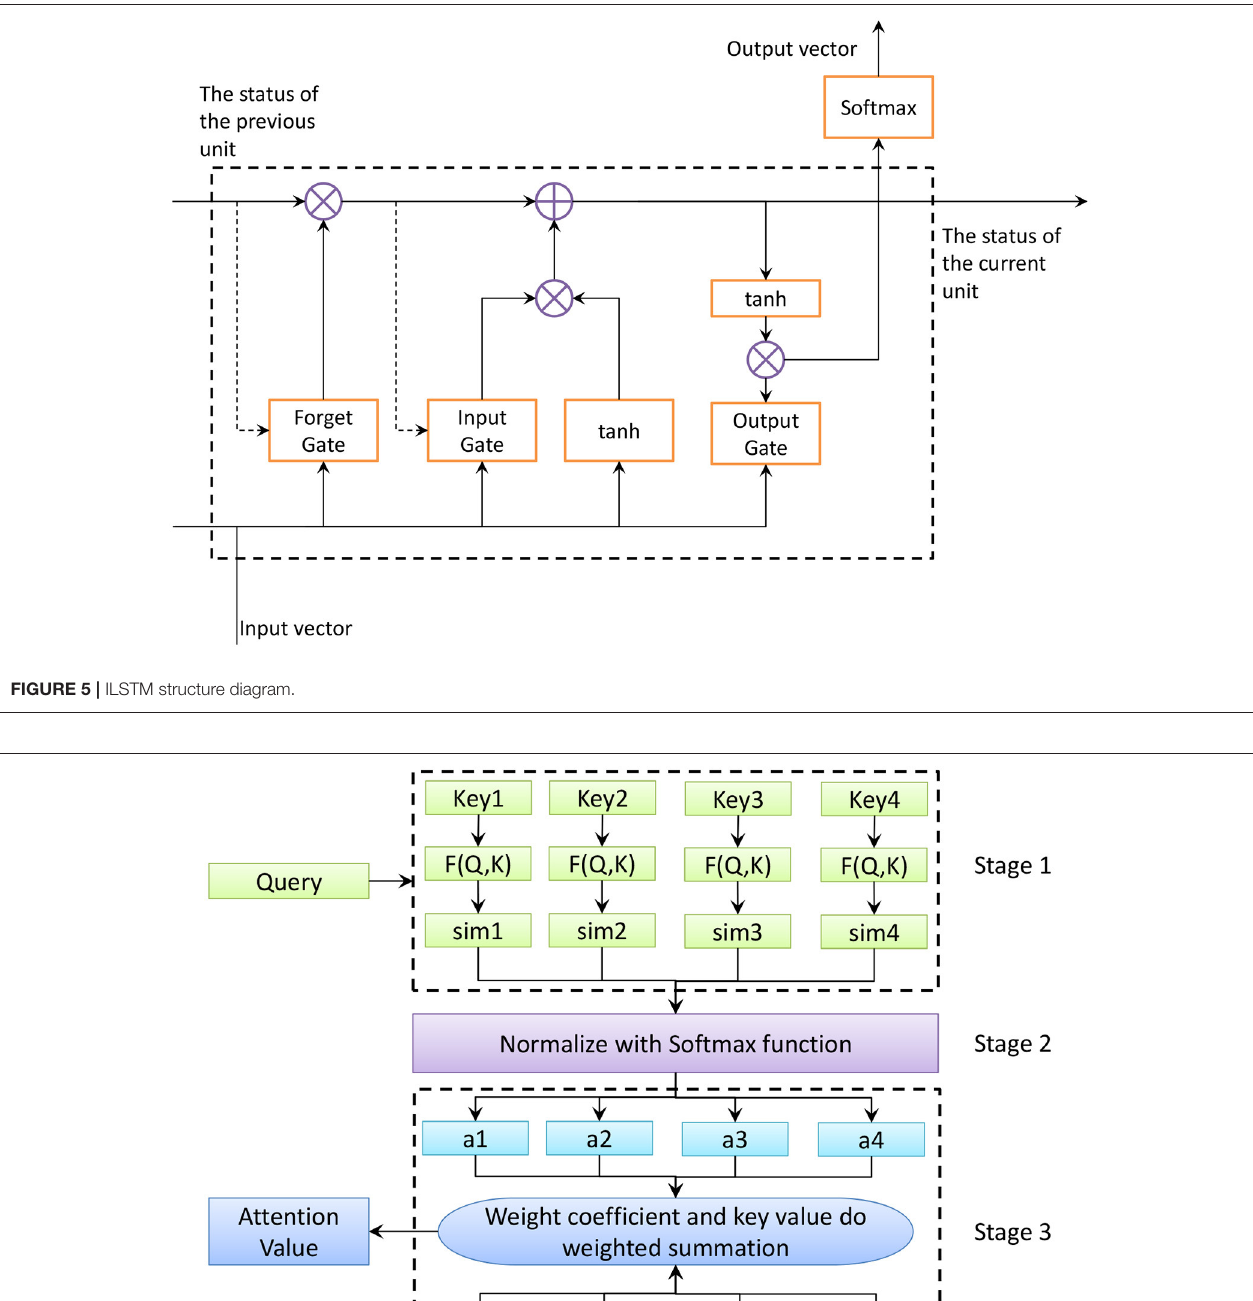
the effect of harmonics. Usually a filter bank contains 22–26 filters. The number of Mel filters used in this article is 128. After calculating the logarithmic energy output by each filter bank, the calculation result is brought into the discrete